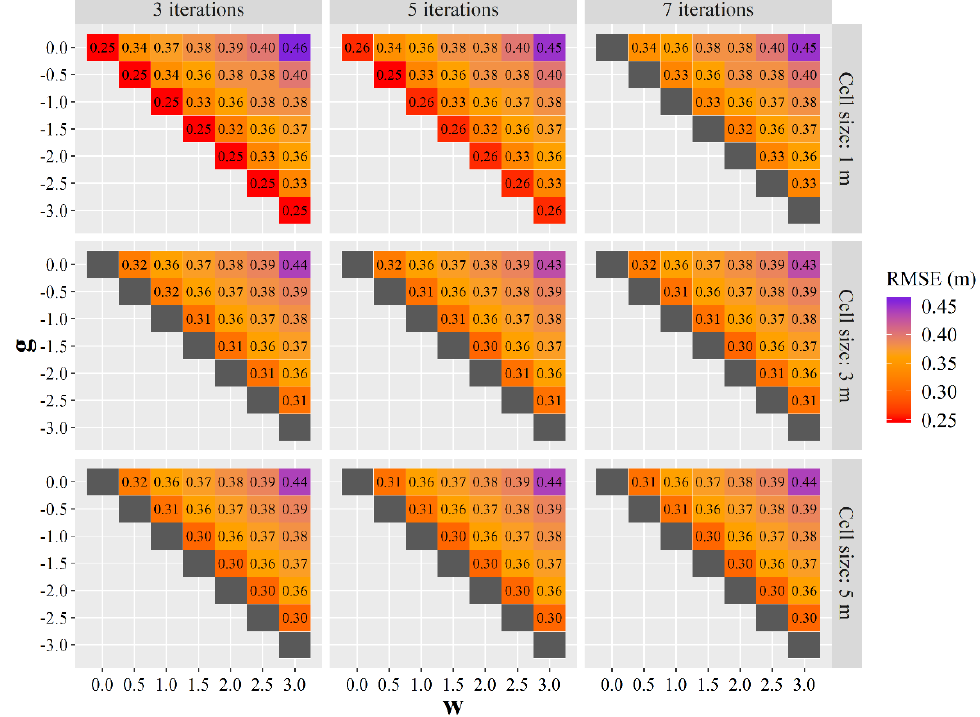
Figure 3. Root mean square error (RMSE) values of the digital terrain models (DTMs) derived from the calibration of the parameters of the weighted linear least-squares interpolation (WLS). Grey tiles represent settings that produced eroded DTMs.